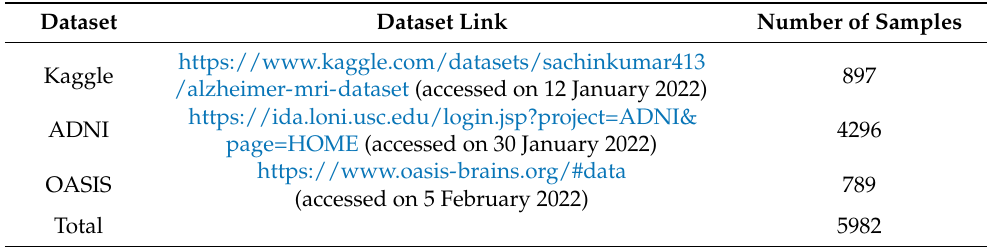
Table 2. Fused MRI dataset